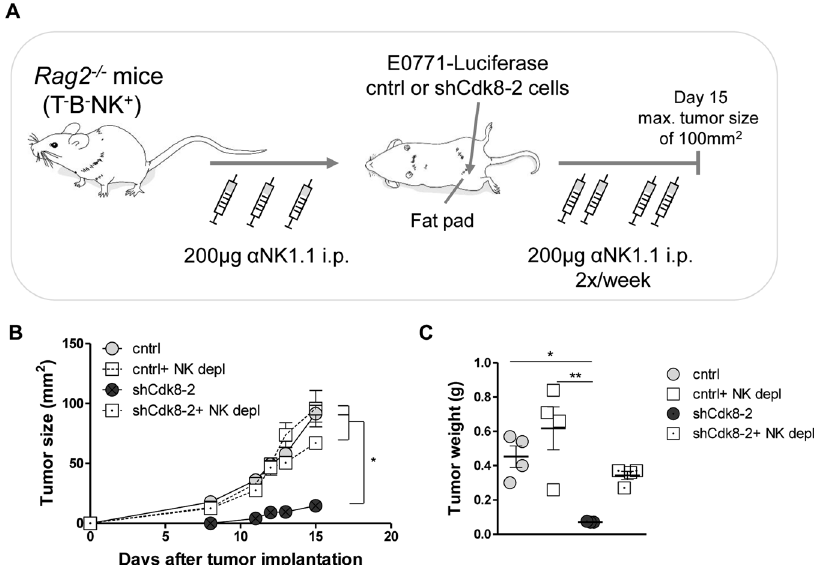
Fig. 5 NK-cell depletion allows outgrowth of CDK8-de fi cient TNBC tumor cells. A Experimental setup of data shown in ( B , C ). Rag2 − / − mice were NK-cell depleted by i.p. injections of an α NK1.1 antibody (200 µg/mouse), three times prior to implantation of E0771 control or shCdk8-2 cells and subsequently twice per week. B Primary tumor growth of control vs. shCdk8-2 E0771 cells, of mice treated with α NK1.1 antibody (PBS injection served as control). Symbols and error bars represent tumor size (mm 2 ) in mean ± SEM. C Tumor weight of mice at day 15 after tumor implantation at the endpoint of the experiment ±SEM ( n = 4 mice per group).